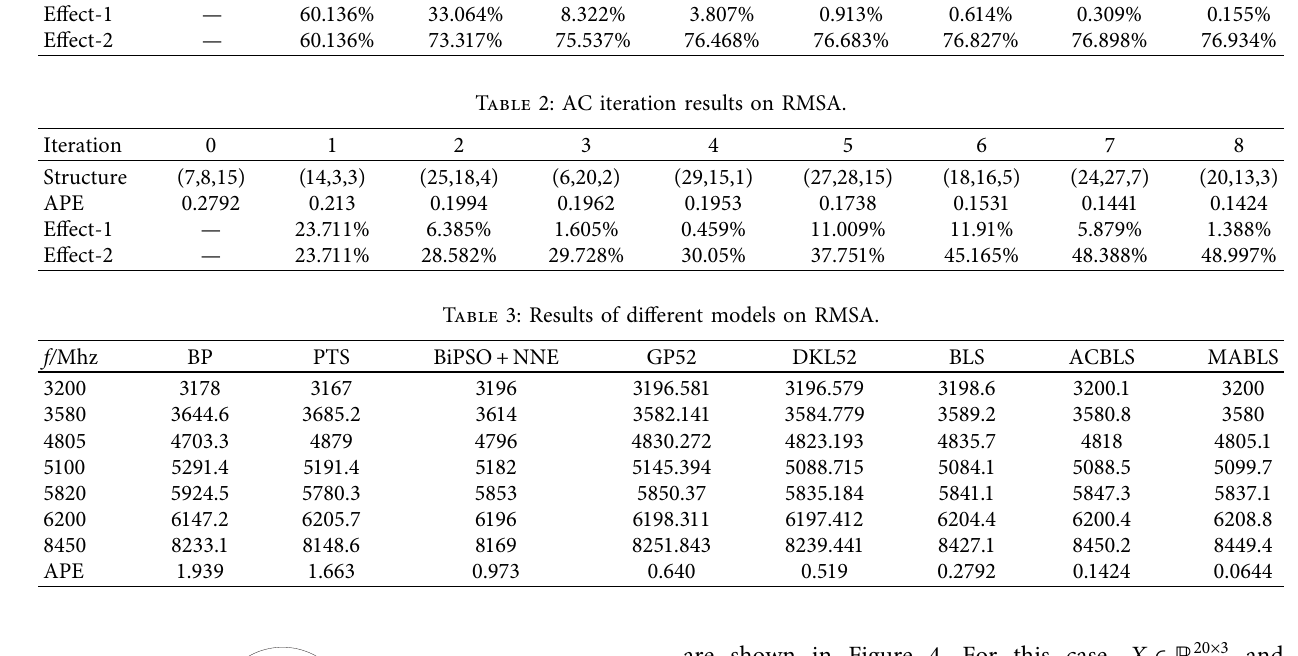
are shown in Figure 4. For this case, X ∈ R 20 × 3 and Y ∈ R 20 × 1 . All experimental data are tabulated in Table 4,